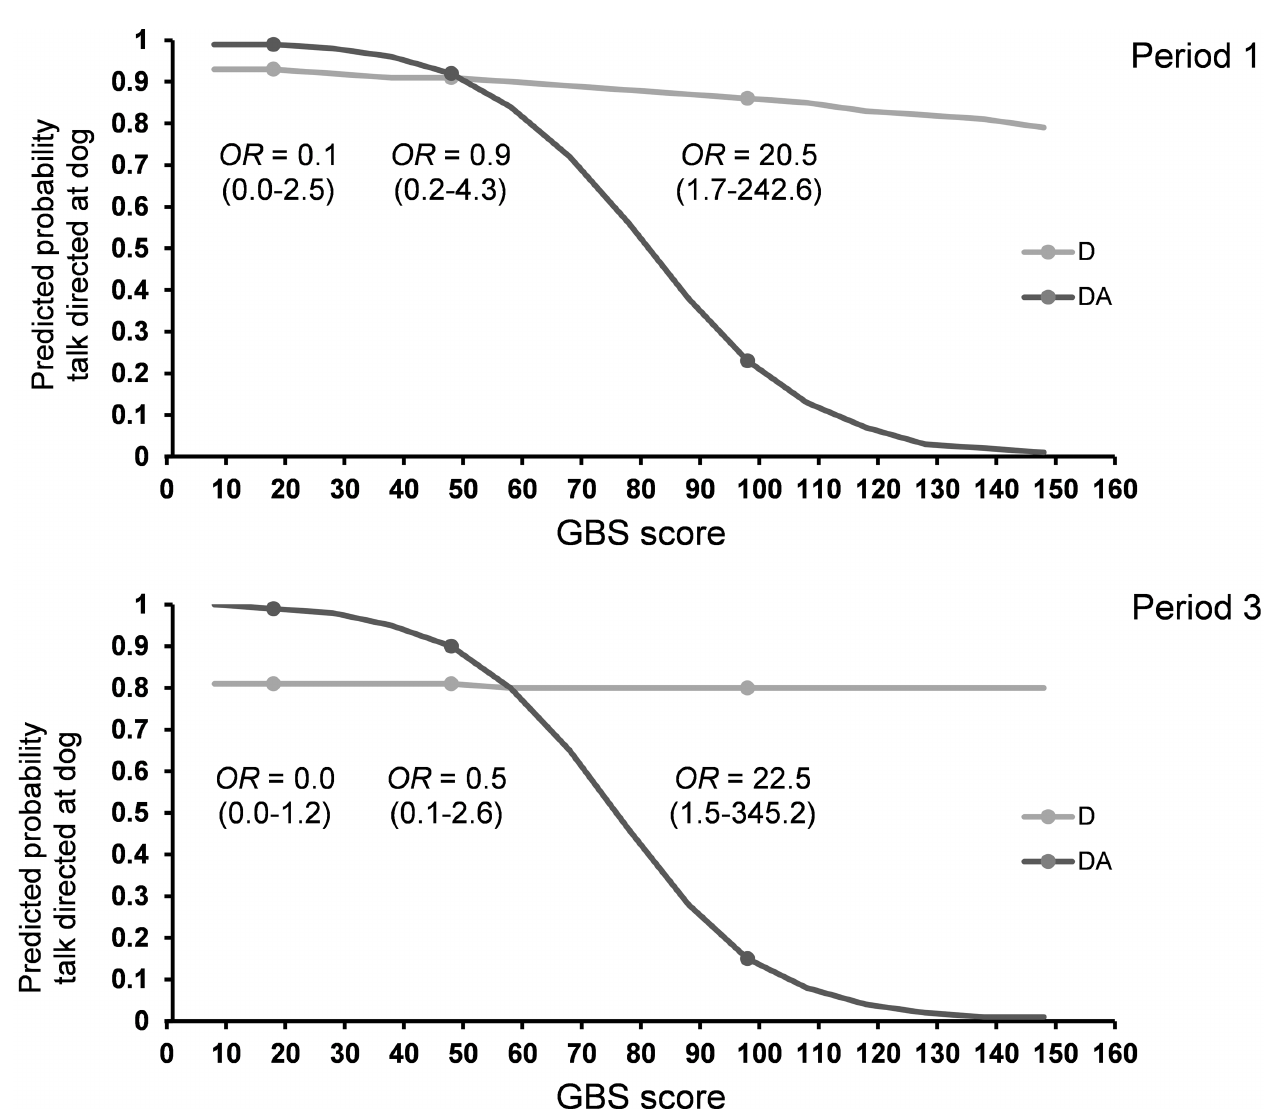
Fig 5. Predicted probability for talking directly to the dog in periods 1 and 3 estimated for the range of GBS scores and separately for D and DA visits. D: visits with a dog, no activity, DA: visits with a dog, with activity. GBS scores of 18, 48 and 98 are marked with a dot. The odds ratios (OR) for each of these GBS values are shown. The Gottfries-Br å ne-Steen Scale